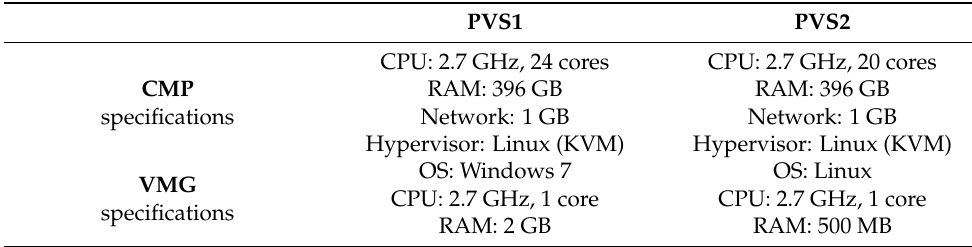
Table 1. PVSs for cluster platform.